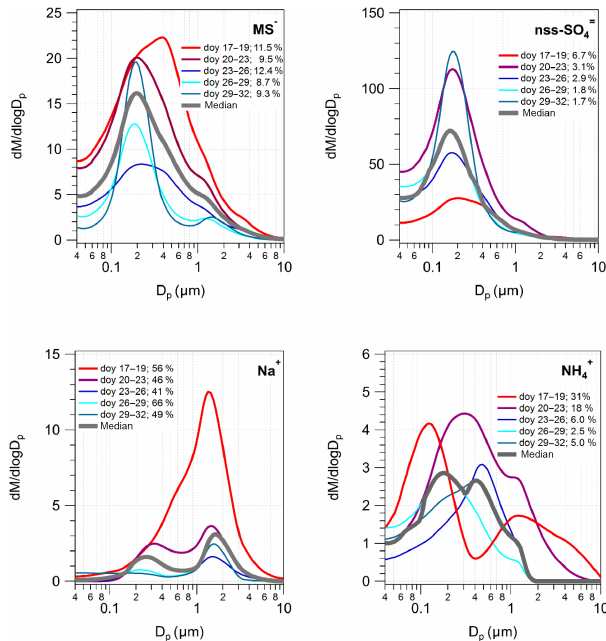
Figure 11. Results from size-segregated (Berner impactor) sam- pling during the campaign 2015. Bold reddish lines are the mass size distributions during LPS15. Percentage entries in the leg- end denote the portion of the corresponding ion mass in the size range >1µm (super-micrometer or coarse mode) calculated from the inverted profiles. The bold gray line is the median mass size distribution of the corresponding